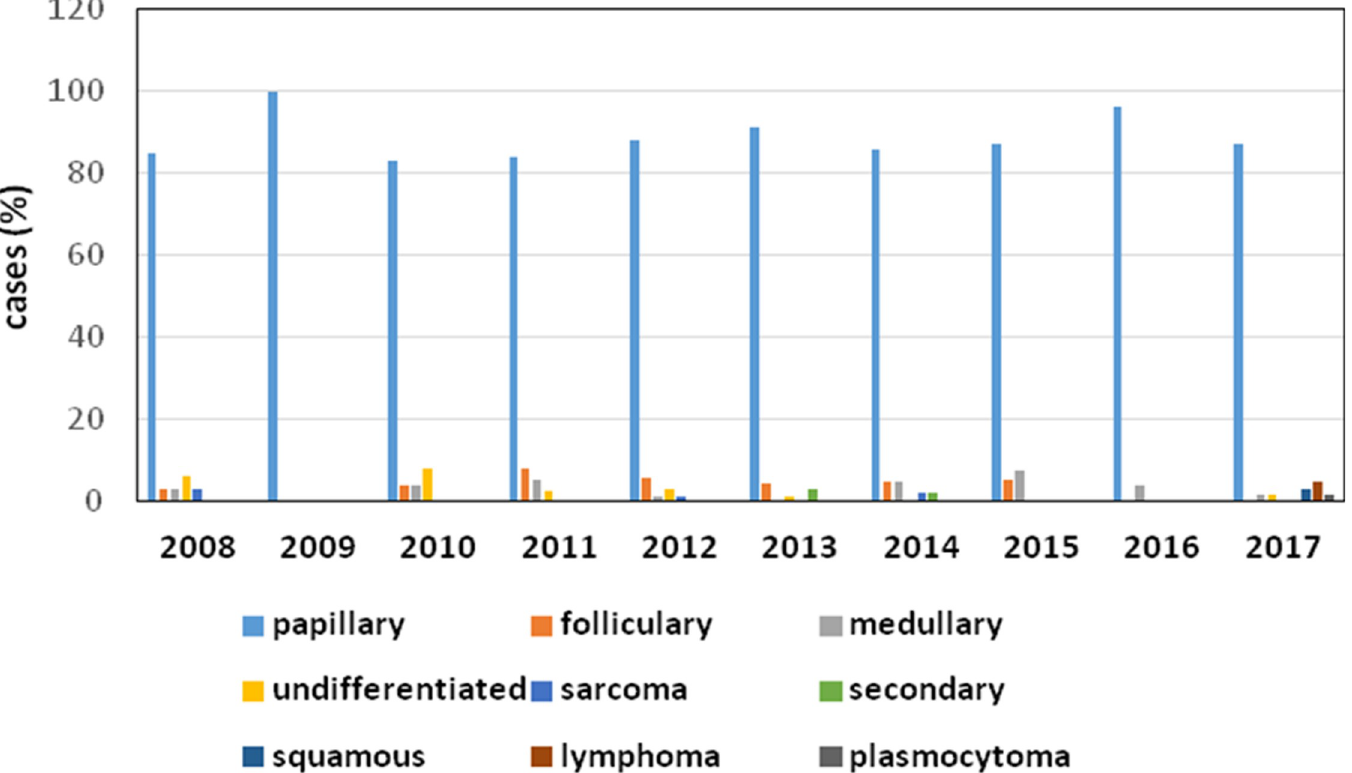
Fig 4. Percent of patients diagnosed with the histopathological types of thyroid cancer from